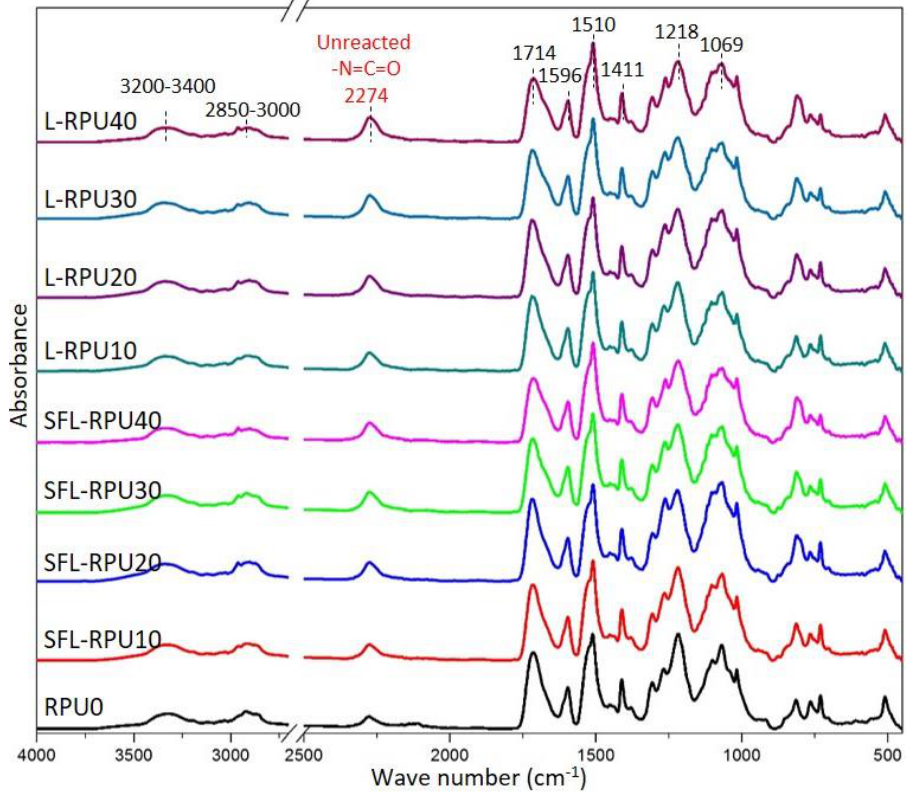
Figure 6. FTIR spectra RPU foams containing 0–40% lignin.